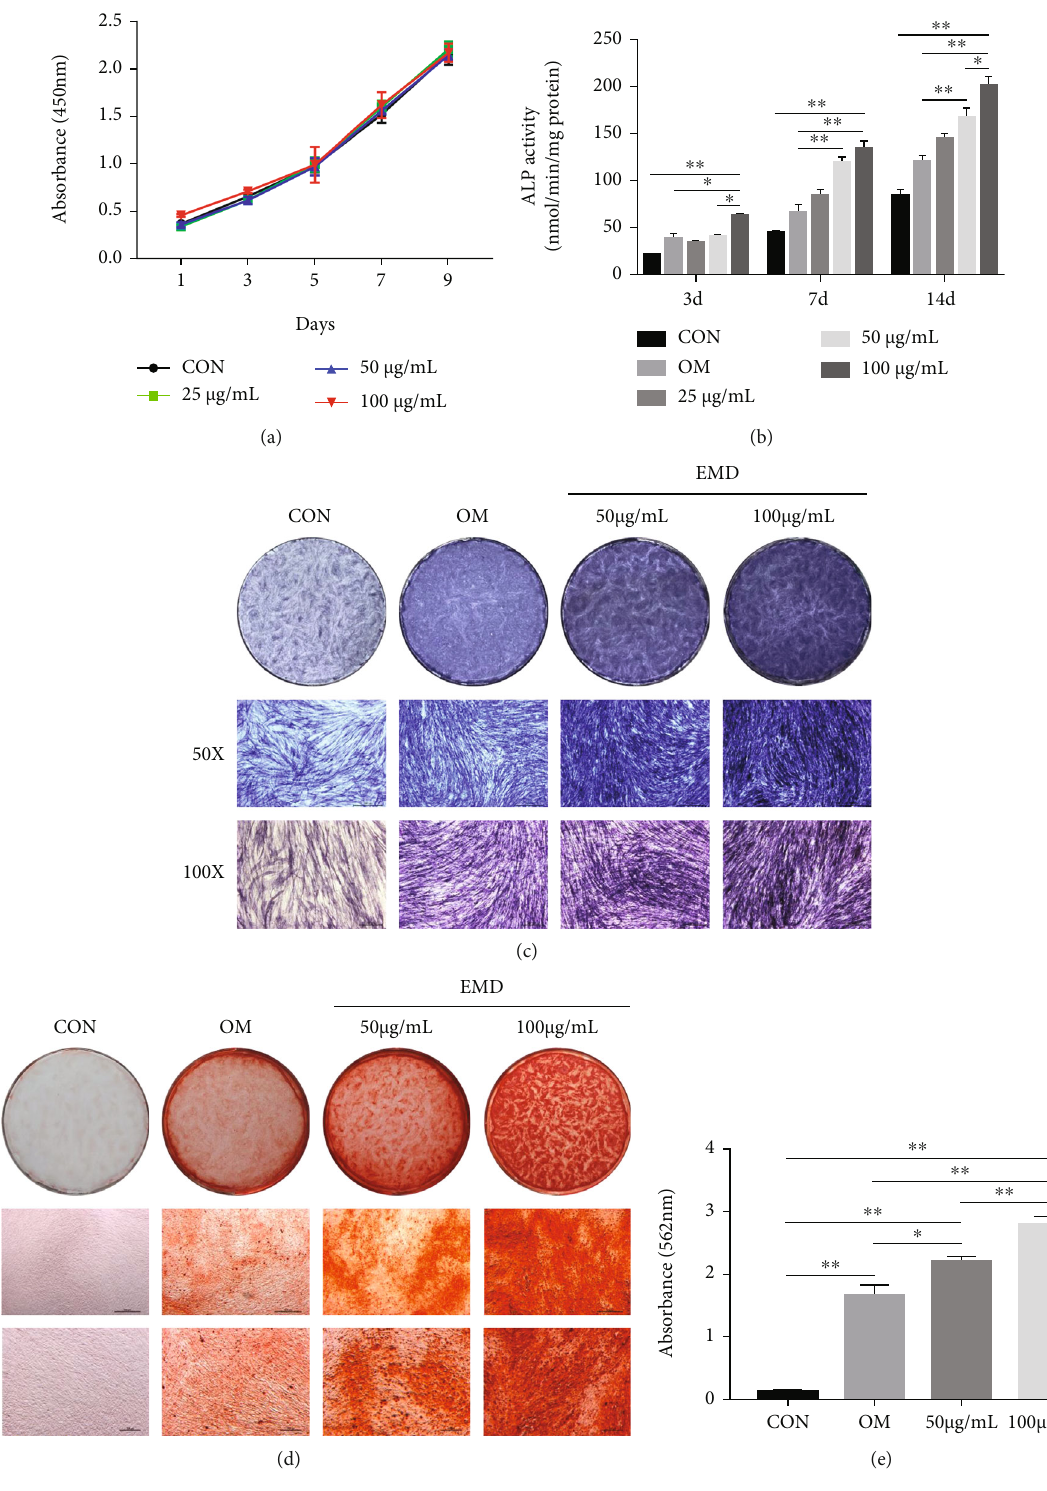
Figure 2: Screening for the optimal concentration of EMD and investigating the proliferation of EMD-treated DPSCs. (a) The e ff ect of EMD on DPSCs proliferation was detected by a cell counting kit-8 assay on days 1, 3, 5, 7, and 9. (b) The ALP activity of DPSCs treated with various concentrations of EMD for 3, 7, and 14 days, respectively. (c) ALP staining of DPSCs treated with 50 and 100 μ g/mL of EMD at day 7. (d) and (e) Alizarin red staining and quanti fi cation of EMD-treated DPSCs at day 14. The results are presented as means ± SD of three independent experiments ( n =3). ∗ P < 0 : 05 , ∗∗ P < 0 : 01